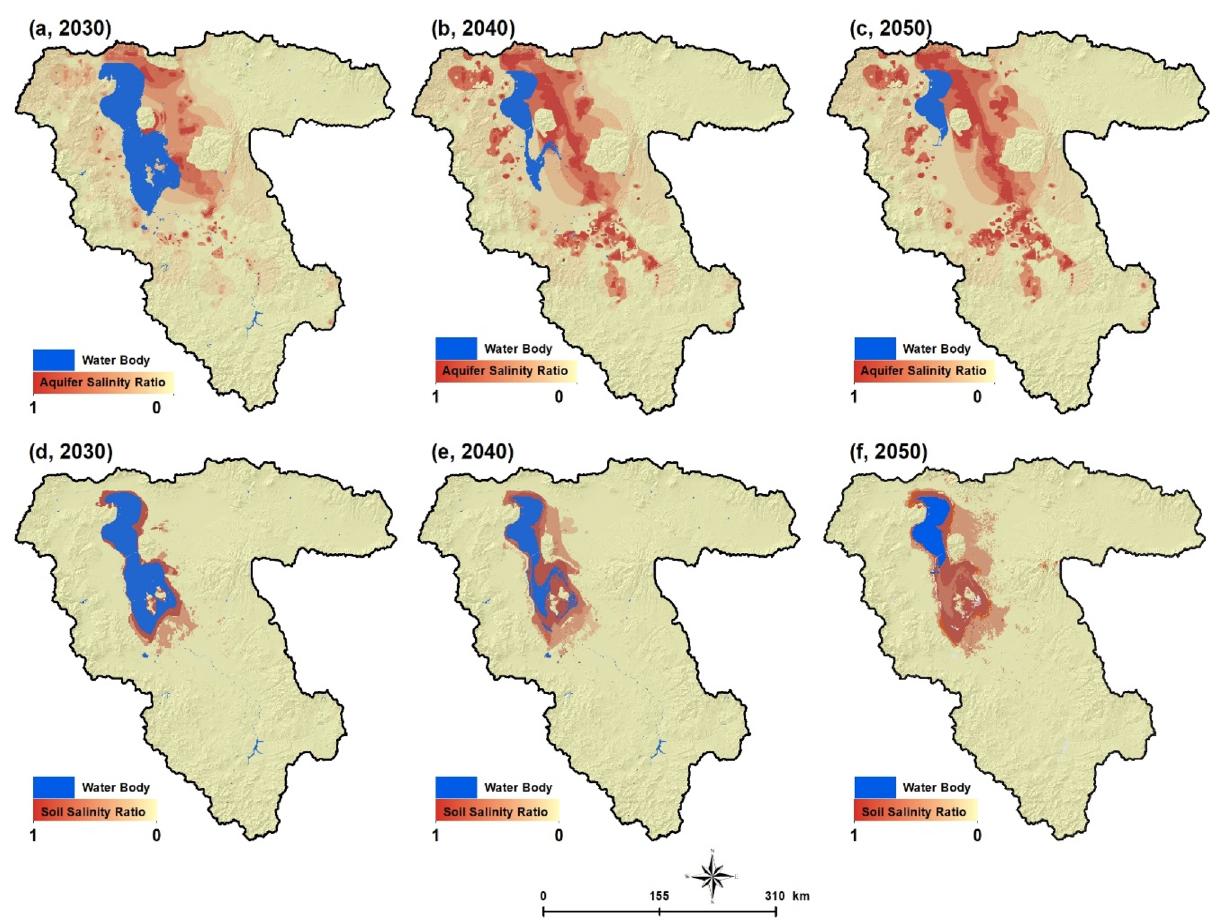
Figure 6. Results of simulation using a CA-Markov: aquifer salinization for 2030 ( a ), 2040 ( b ), 2050 ( c ) and soil salinization for 2030 ( d ), 2040 ( e ) and 2050 ( f ). Red color indicates the extension of soil and aquifer